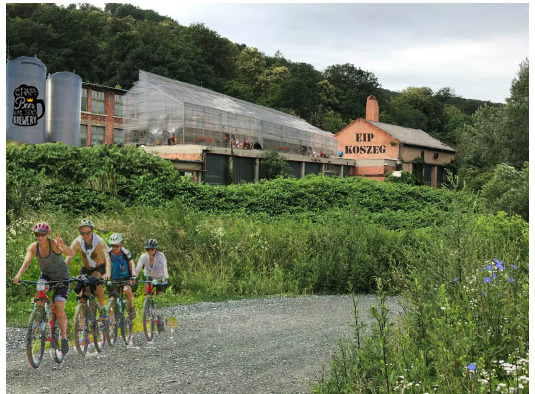
Figure 9. Rendering of K ˝ oszeg Eco-Innovation Center